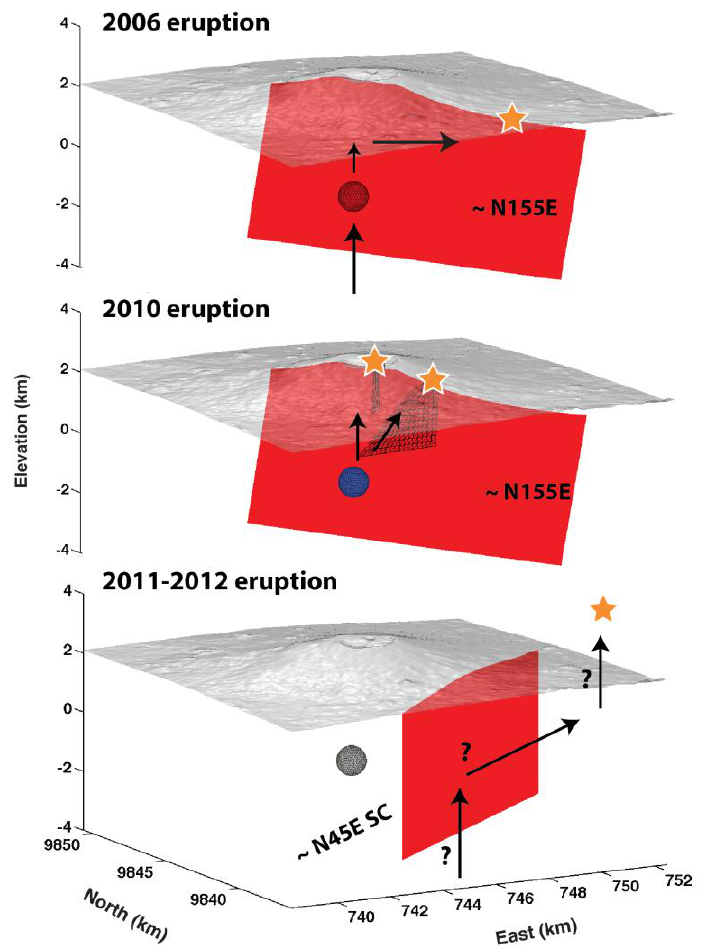
Figure 7. Schematic shallow magma plumbing system for the period 2006–2012. Arrows represent possible magma migration paths. Red and blue sources experience inflation and deflation, respectively. Orange stars denote the locations of eruptive fissures and vents. SC stands for south of the caldera. The two dikes and magma reservoir inferred from the modeling of the 2010 eruption data are represented with black